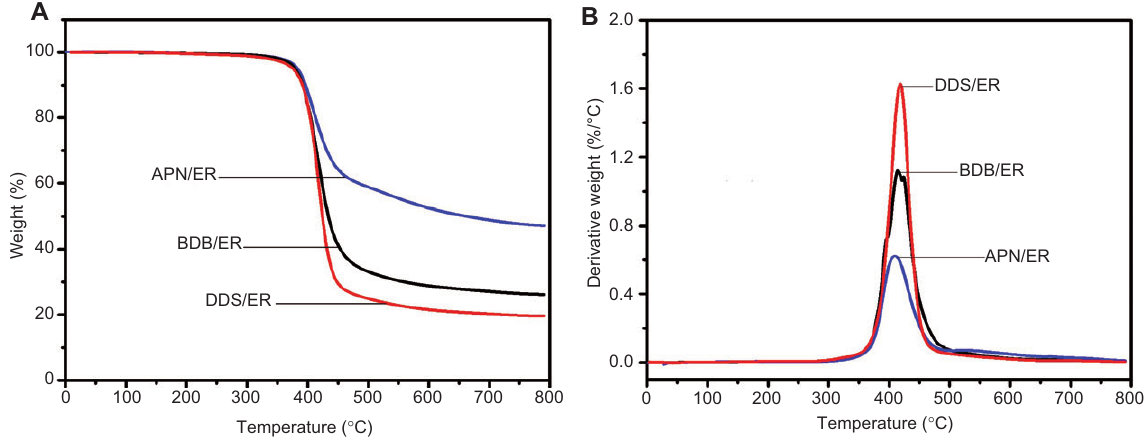
Figure 4 TGA (A) and DTG (B) curves of amine/epoxy copolymers in nitrogen.